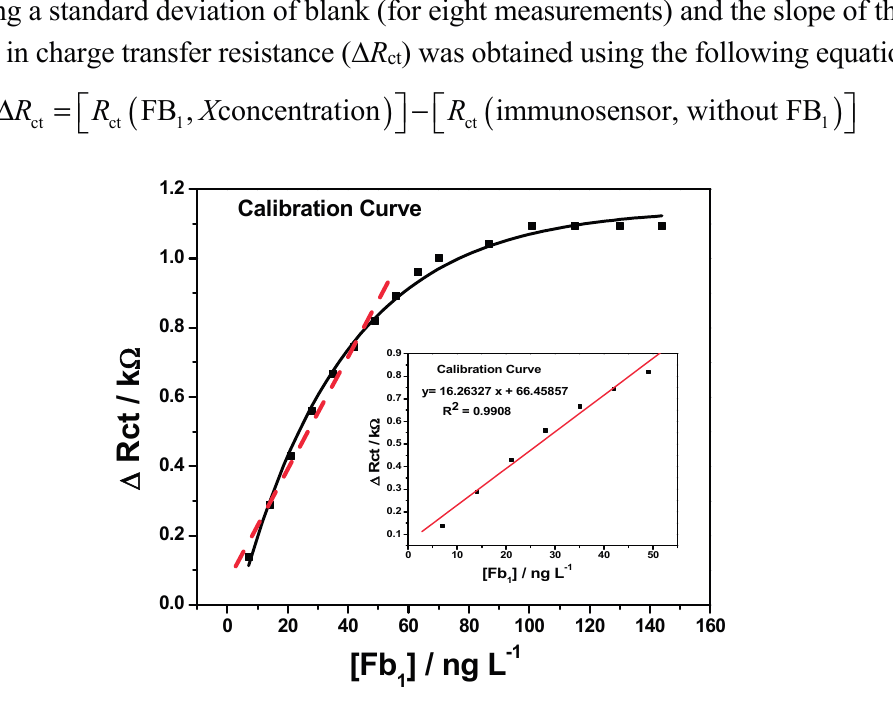
Figure 11. Calibration plot for GCE/PT-PDMA-MWCNT/anti-Fms-BSA